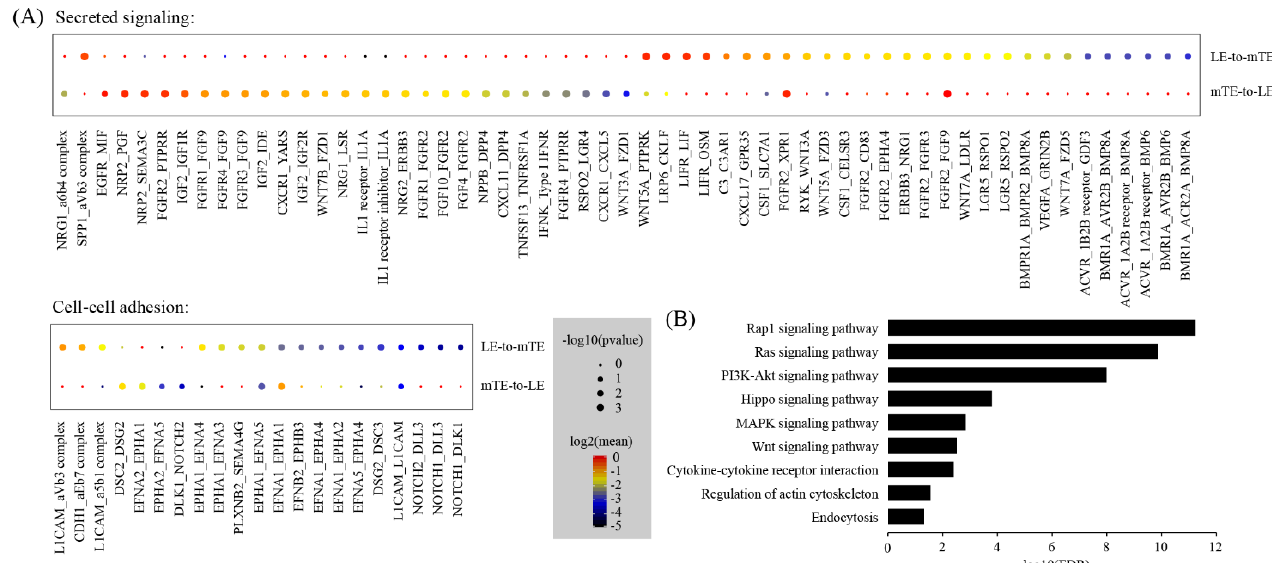
Figure 5. Cell–cell communication between mTE and LE: ( A ) Dot plot showing selected ligand–receptor interactions underly- ing mTE-LE crosstalk. p -values are indicated by circle size and means of the average expression level of interacting molecule are indicated by color; ( B ) KEGG Pathway enrichment analysis of ligand–receptor pairs by using the DAVID online tools.